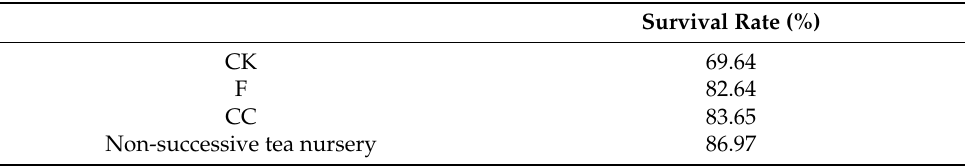
Table 2. The survival rate in different tea nurseries.